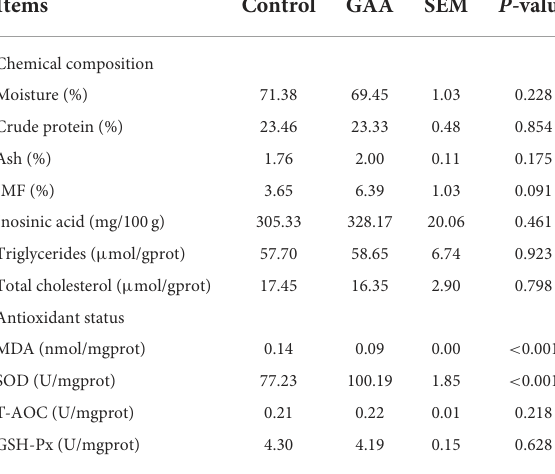
TABLE 4 Effect of dietary GAA on free amino acid contents of Longissimus thoracis in Tibetan pigs (mg/100g based on wet weight).